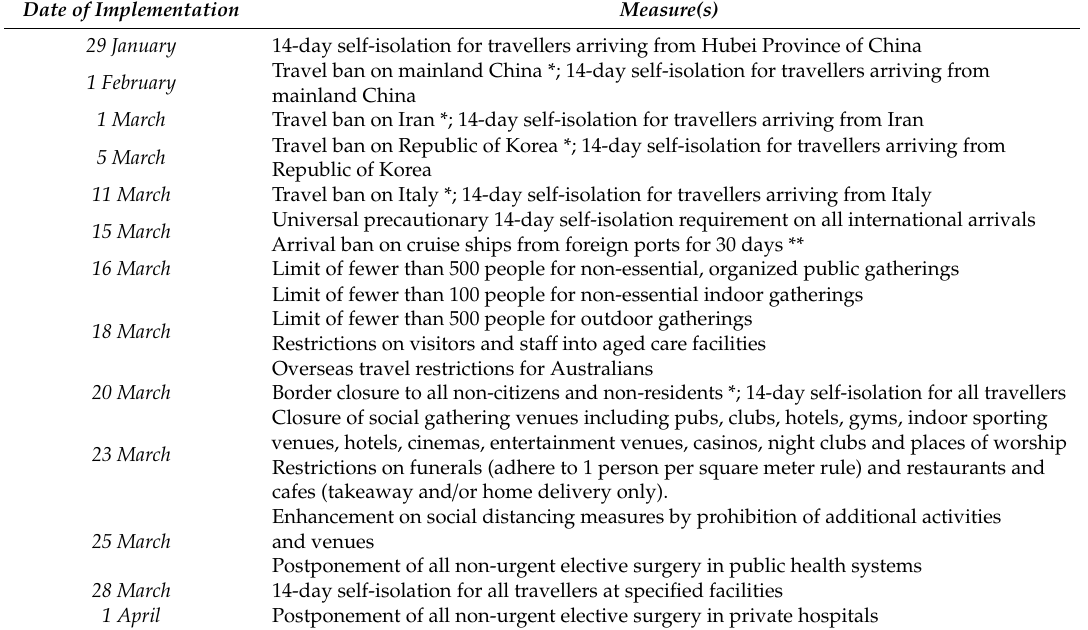
Table 4. National non-pharmaceutical intervention measures implemented in Australia during the COVID-19